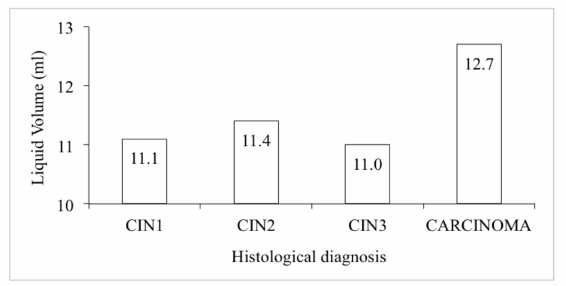
Figure 2. Mean size of residual liquid by histology.